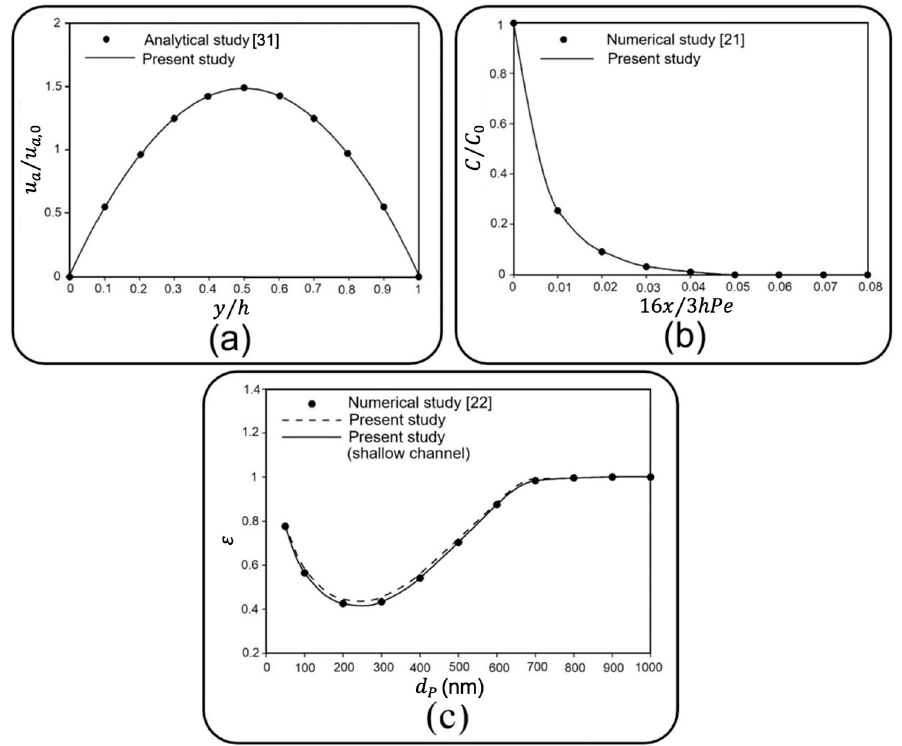
Figure 3. Comparison of the present numerical results with ( a ) analytical data in Ref. [31] for a 2D airflow between two parallel plates. Axial fluid velocity and vertical distance from the substrate are normalized with respect to the inlet velocity of 0.3 mm/s and the channel height of 100 µ m. Subsequently, ( b ) numerical data in Ref. [21] is shown for the mean concentration of particles with a diameter of 1 µ m along two parallel plates. Distance from the entrance and particle concentration are nondimensionalized, respectively, with respect to a specific length of 3 hPe /16, and initial concentration ( C 0 = 10 5 /m 2 ). Pe = 2 uh / D is the Peclet number, and where D 2.96 × 10 − 11 m 2 /s is the diffusion coefficient. Finally, the ( c ) the numerical result of Ref. [22] for deposition rate of NPs with various diameters on the substrate of an air channel is shown.